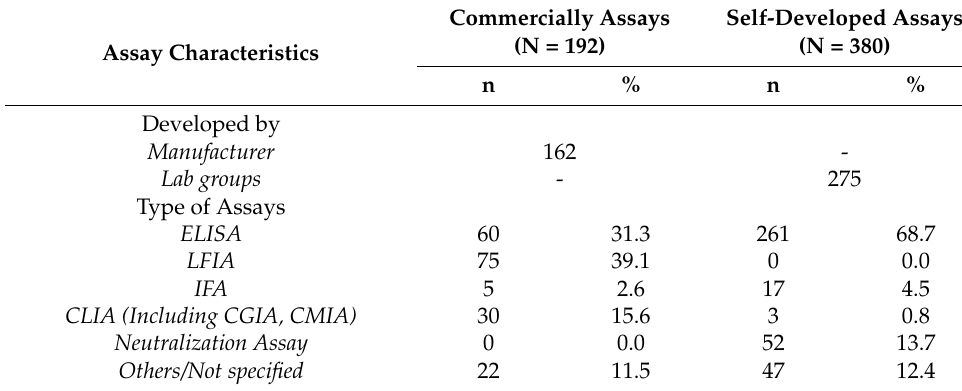
Table 1. Features of commercial and self-developed serology assays used by studies.